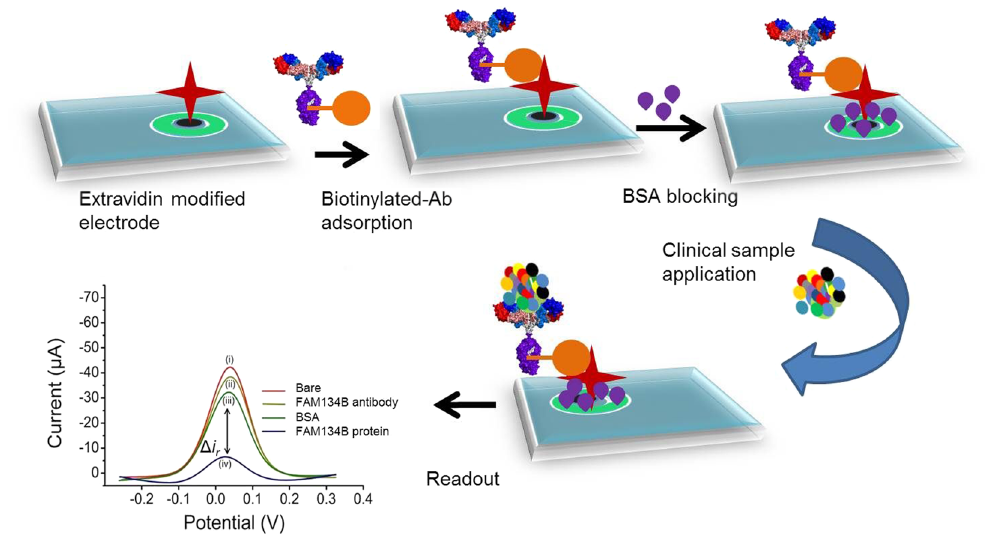
Figure 1. Approach for the detection of FAM134B protein in colon cancer. Schematic showing the steps involved in the fabrication of electrochemical assay for the detection of FAM134B protein. FAM134B proteins extracted from colon cancer cell lysates and serum samples complexed with surface attached-biotinylated FAM134B antibody which hinders the interfacial electron transfer reaction of [Fe(CN) 6 ] 3 − /4 − . Inset, the DPV current generated at the ( i ) unmodified and ( ii - iv ) modified electrodes. Δ i r is the difference between relative DPV signals obtained at antibody/BSA- and antibody/BSA/antigen-modified